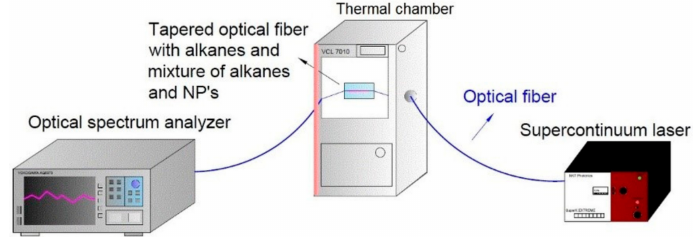
Figure 3. Scheme of a set-up for measuring the transmission of a tapered optical fiber depending on changes of temperature.